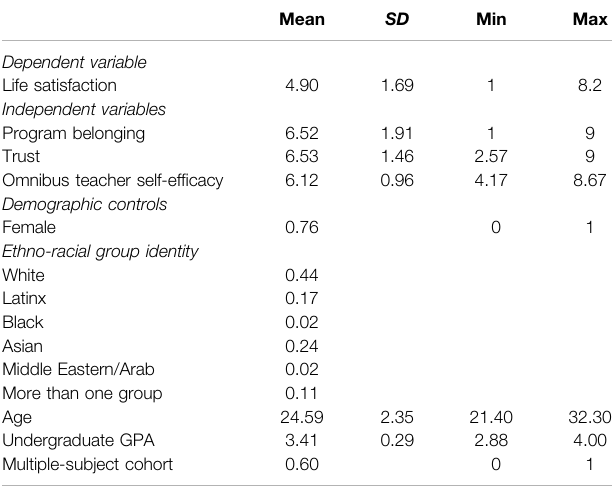
TABLE 1 | Descriptive statistics multiple- and single-subject cohorts ( N (cid:1) 63).